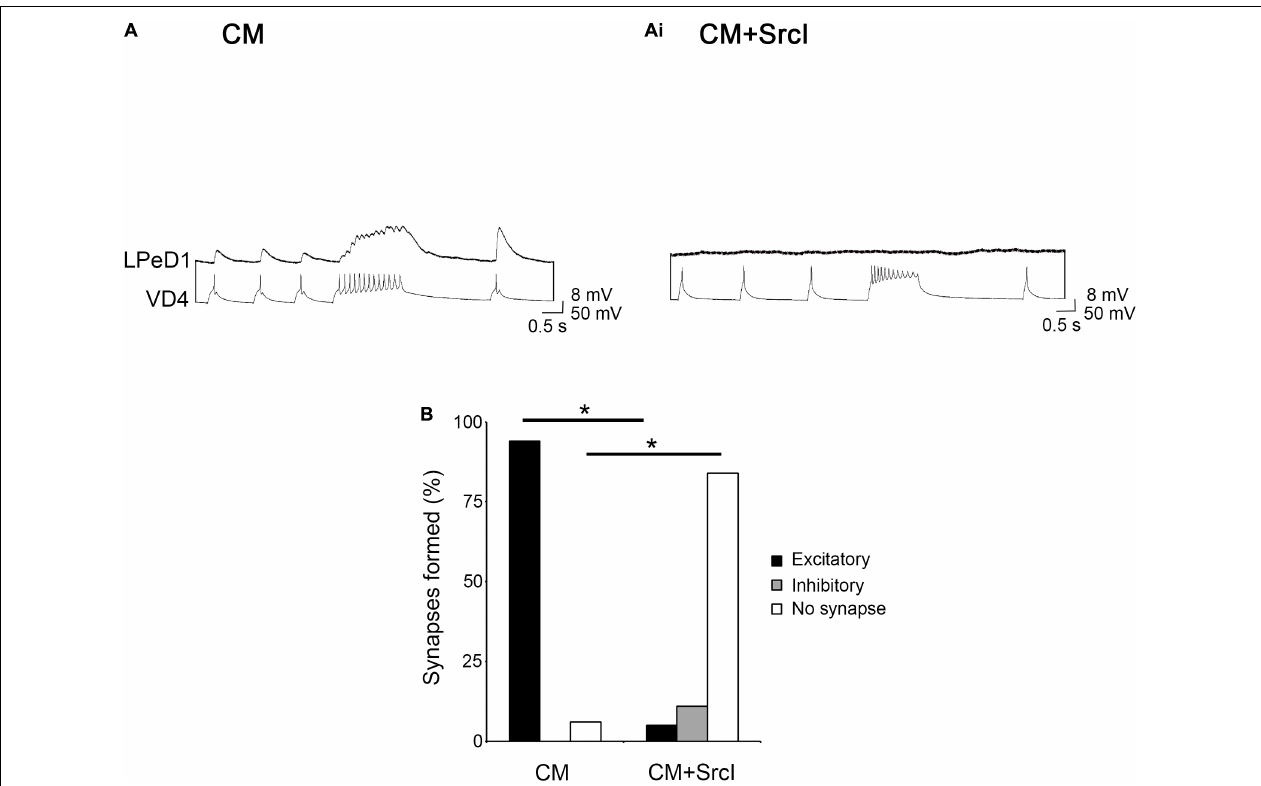
FIGURE 6 | Src family kinases (SFKs) are required for synapse formation between visceral dorsal 4 (VD4) and left pedal dorsal 1 (LPeD1) neurons paired in a soma–axon configuration. (A) Individual VD4 somata and LPeD1 axons (somata removed) were paired overnight in conditioned media (CM). Both cells were impaled with sharp intracellular electrodes the next day and held at –100 mV for consistency. Action potentials triggered in VD4 induced 1-for-1 EPSPs in LPeD1 ( n = 31). (Ai) A separate group of soma–axon pairs were cultured in CM + SrcI (5 µ M) overnight ( n = 19). SrcI perturbed synapse formation in these pairs, as was demonstrated by the lack of response in LPeD1 to action potentials triggered in VD4. (B) Summary of the percentage of soma–soma pairs that formed synapses, with a significance of p ≤ 0.001, as determined using Pearson’s chi-squared